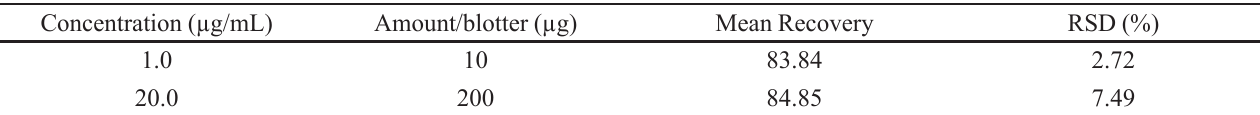
TABLE III - Mean recovery at two different levels of concentration and respective relative standard deviation Concentration (µg/mL) Amount/blotter (µg)